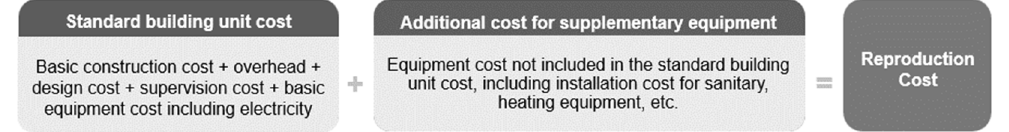
Figure 2. Composition of building reproduction cost.